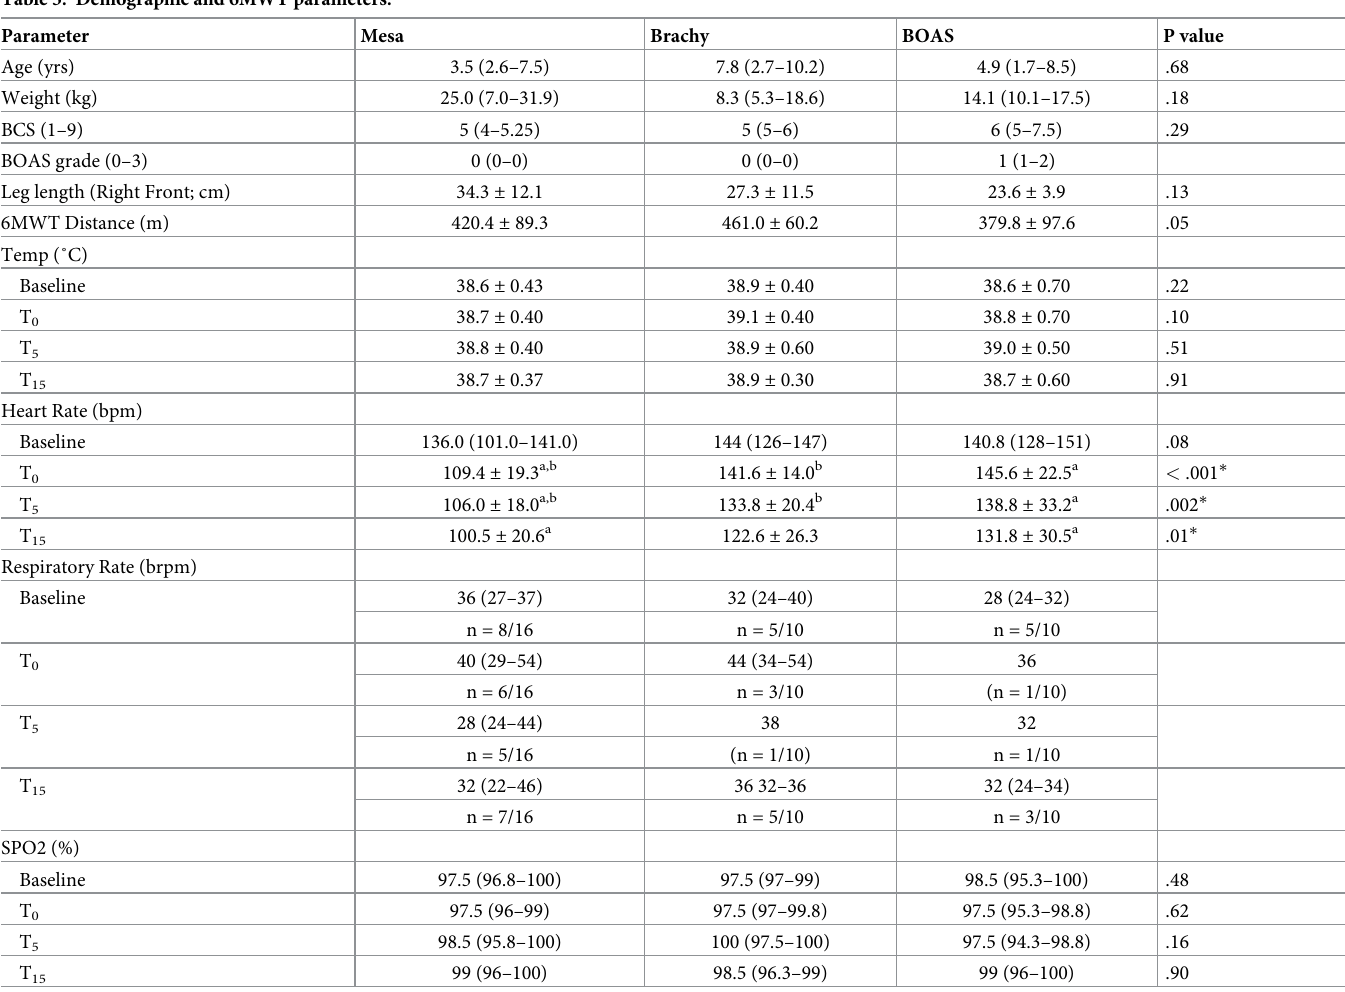
Table 3. Demographic and 6MWT